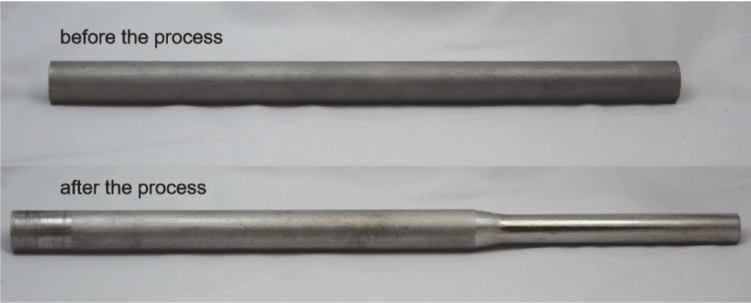
Figure 6. Workpiece before and after rotary swaging.